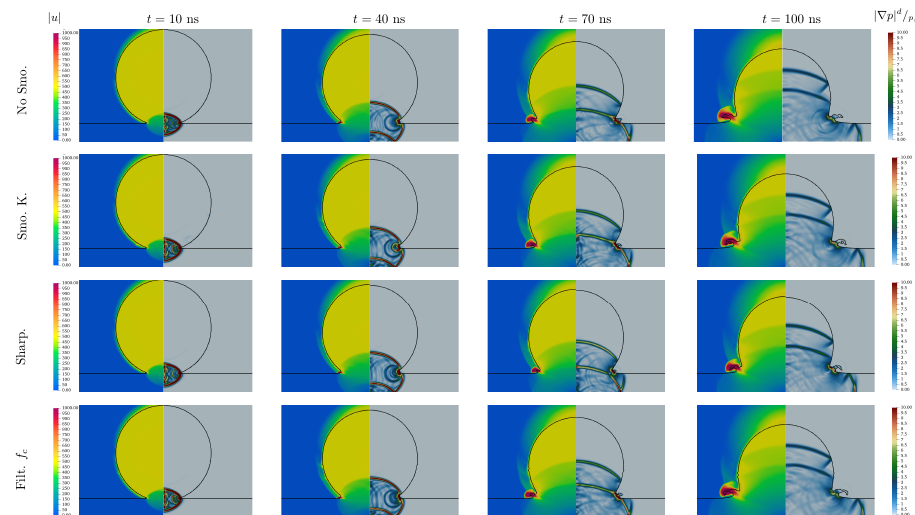
Figure 10. Velocity and pressure gradient distribution within the droplet for the different smoothing strategies cases at different instants. Black line represents the iso-line of α = 0.5.